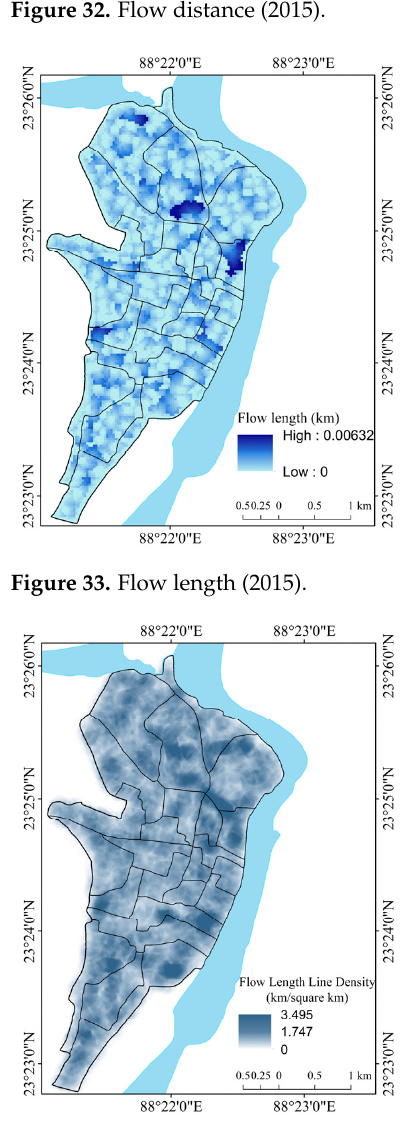
Figure 34. Flow length line density (2015).